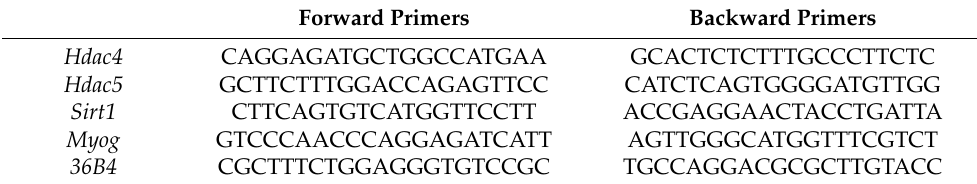
Table 1. List of forward and backward primers used in this